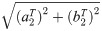
Final droplet speed (right axis) and k = 2 mode shape parameter (calculated as (a2T)2+(b2T)2 from Eqs (25) and (26) at time t = T, left axis) plotted against droplet surface tension.The simulations use ζΔμ = 1.5 and ν = 1.1. Inset shows the swimming steady state for γ = 1 where the shading is a Schlieren texture representation of the polarisation field for crossed x-y polarisers such that dark regions represent areas where the polarisation is parallel or antiparallel to the x or y direction (or isotropic as is the case outside the droplet). The blue arrows show the flow field in the fluid (averaged over neighbouring points for clarity), while the blue line traces the droplet interface. Other parameters were set as listed in Tables 1 and 3 with K = 0.1.